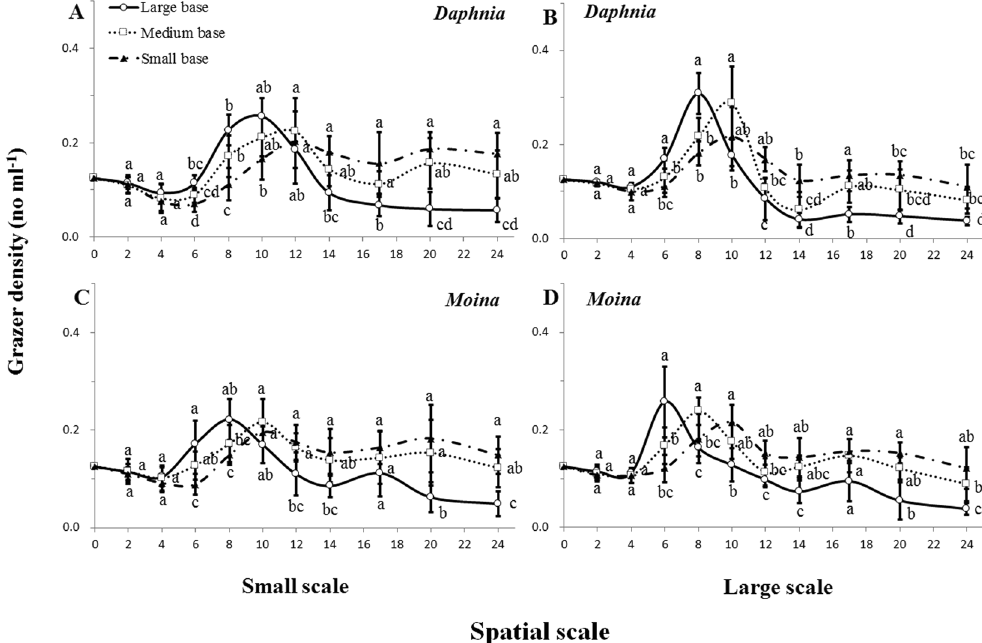
Figure 5. Grazer density (means ± 1 s.d., n = 6) of Daphnia magna ( A , B ) and Moina micrura ( C , D ), with green alga Chlorella pyrenoidosa as the exclusive diet, under three levels of habitat orientation and two levels of spatial scale. Different letters indicate significant differences among treatments on a specific day. Multiple comparisons of means were performed using Tukey’s test at the 0.05 significance level. Figure 5 was created using Microsoft Excel